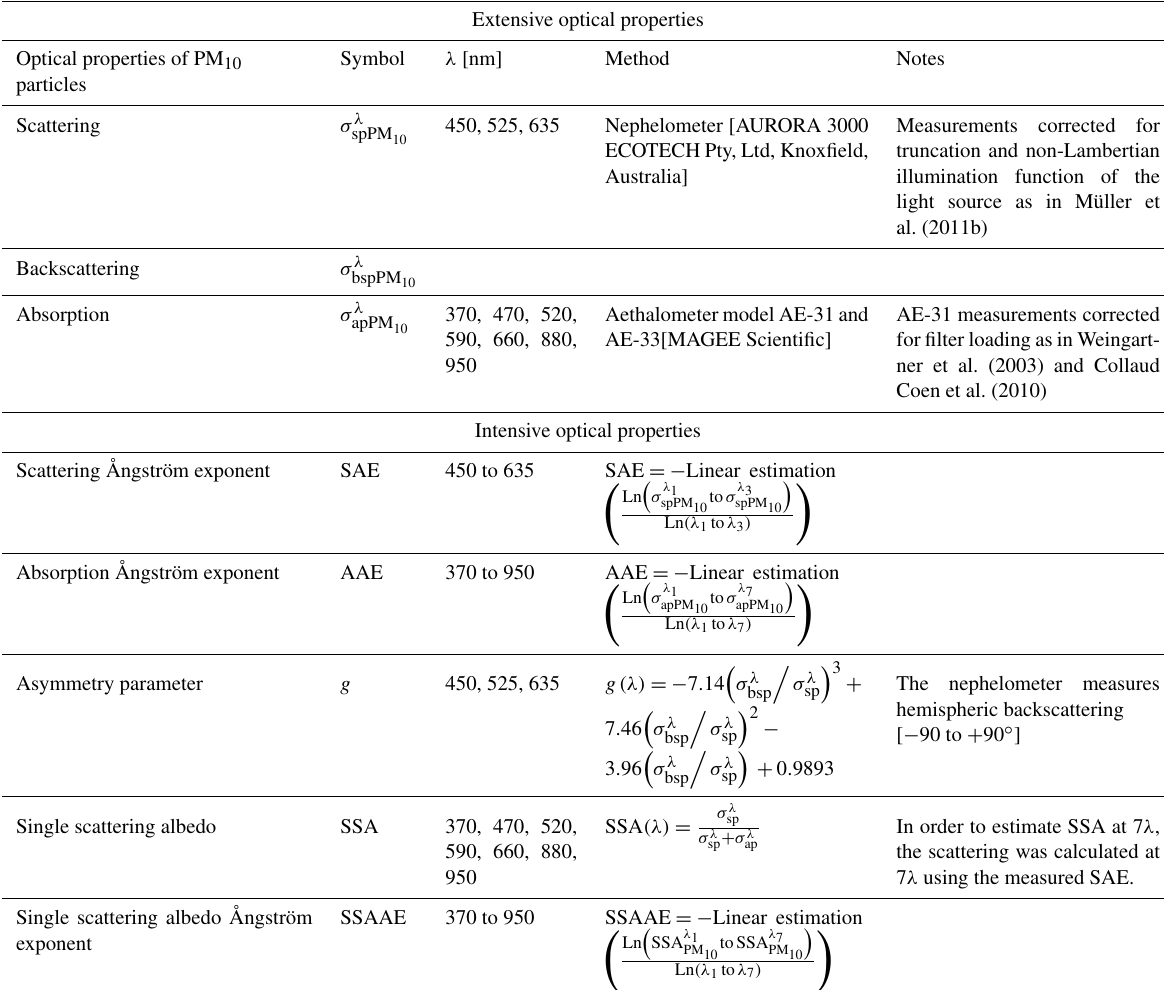
Table 1. Extensive and intensive aerosol optical properties measured and derived respectively in this work. Extensive optical